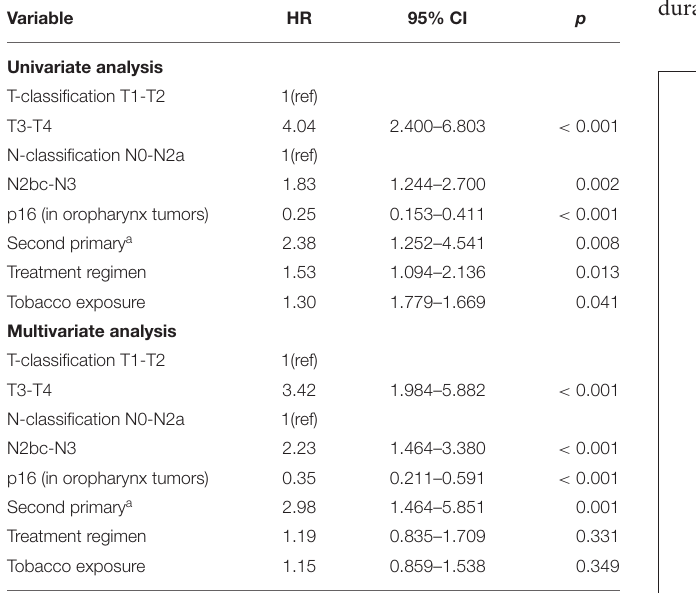
Frontiers in Oncology |